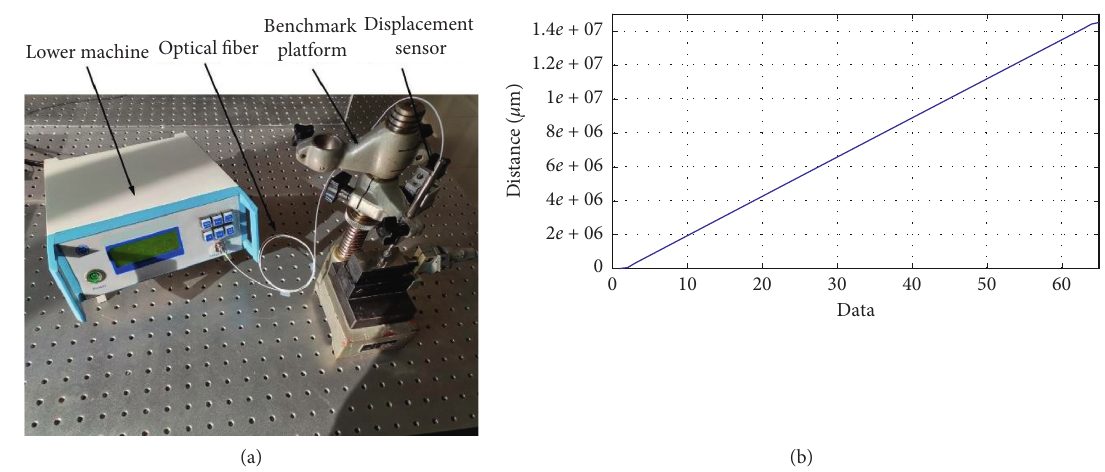
Figure 11: Displacement sensor measurement experiment. (a) Experimental device. (b) Full range linear curve of displacement